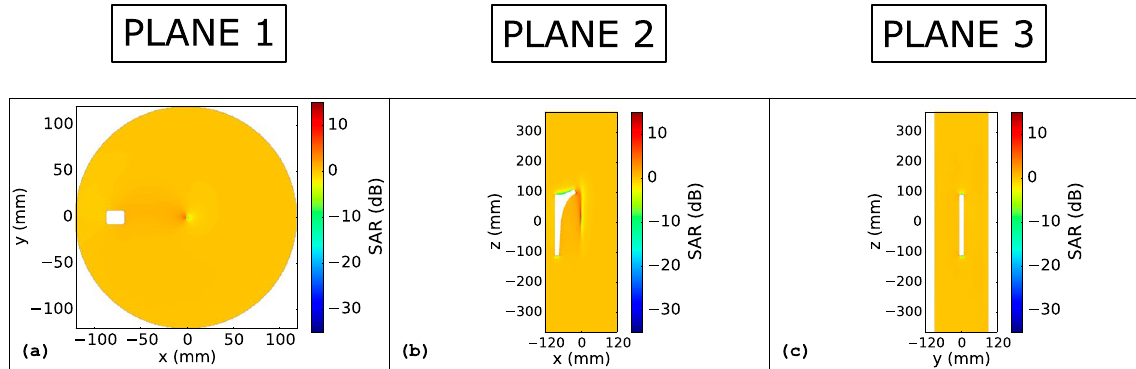
Figure 8. SAR: Lateral coated hip prosthesis. Ratio between the SAR distribution with the coated metallic hip prosthesis inside the phantom and the one without any object. Figures refer to the object plunged into a lateral position inside the phantom. Figure ( a ) refer to the transverse plane that cuts the phantom in two equal parts along the longitudinal direction. Figures ( b ) and ( d ) refer to the coronal and sagittal plane, respectively, that cut the prosthesis in two equal